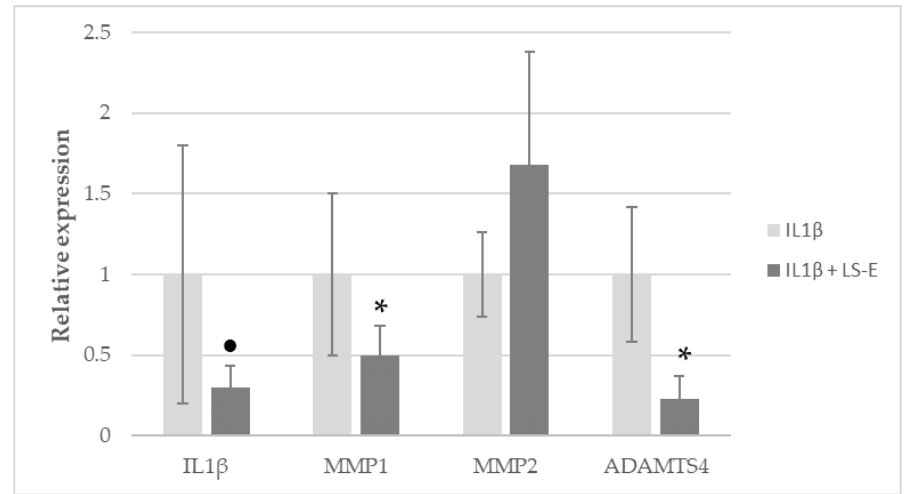
Figure 5. Relative gene expression (expressed as fold change) of IL1 β -activated NHAC-kn in monolayers incubated with LS-E for 4 h (vs. cells incubated with IL1 β and without LS-E), n = 4. Mean values and standard error are given. *: p ≤ 0.05, ● : 0.1 > p > 0.05.